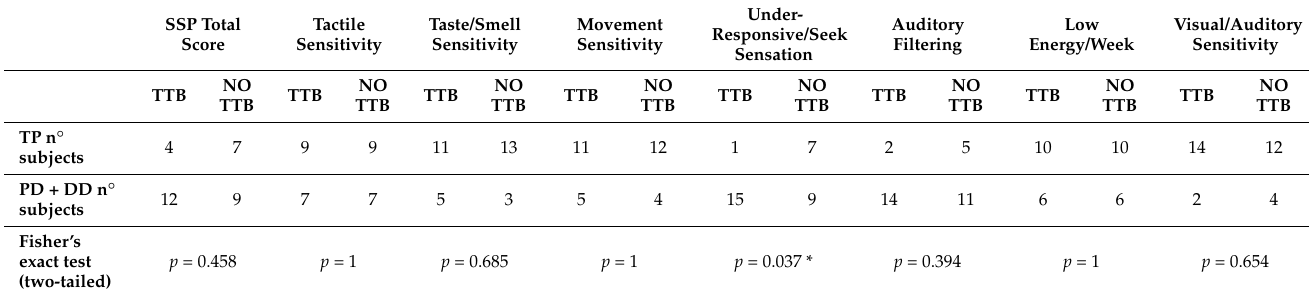
Table 3. Fisher’s exact test results for each section and SSP total